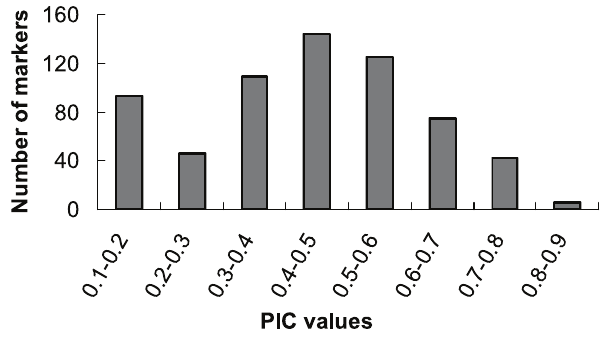
Figure 5. Distribution of PIC values for 642 SSR markers in cucumber. PIC values were calculated from PCR among 11 cucumber inbred lines. doi:10.1371/journal.pone.0005795.g005 matic pachytene length of each chromosome (Table 1). Second, marker clustering around the centromeric region was not detected (Figure 2). Last, the 12 FISH-mapped fosmid clones tagged with 12 SSR markers were evenly distributed across the length of chromosome 6 (data not shown). Only one SSR marker mapped to the heterochromatic region of the chromosome.